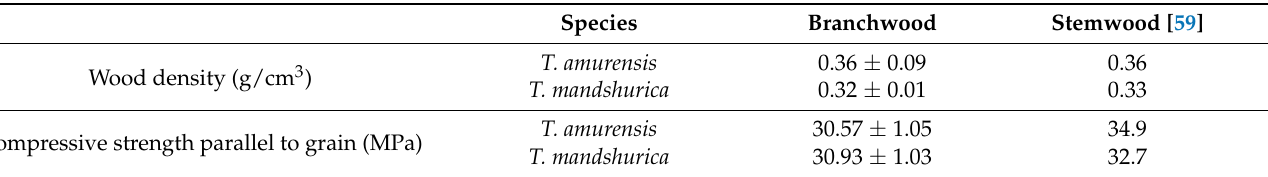
Table 5. Comparison of physical and mechanical properties of the branchwood and stemwood from two Tilia species 1